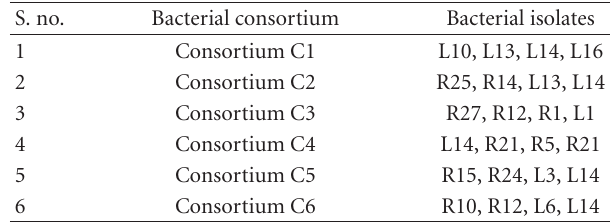
Table 2: Di ff erent consortium consisting of di ff erent bacterial iso-